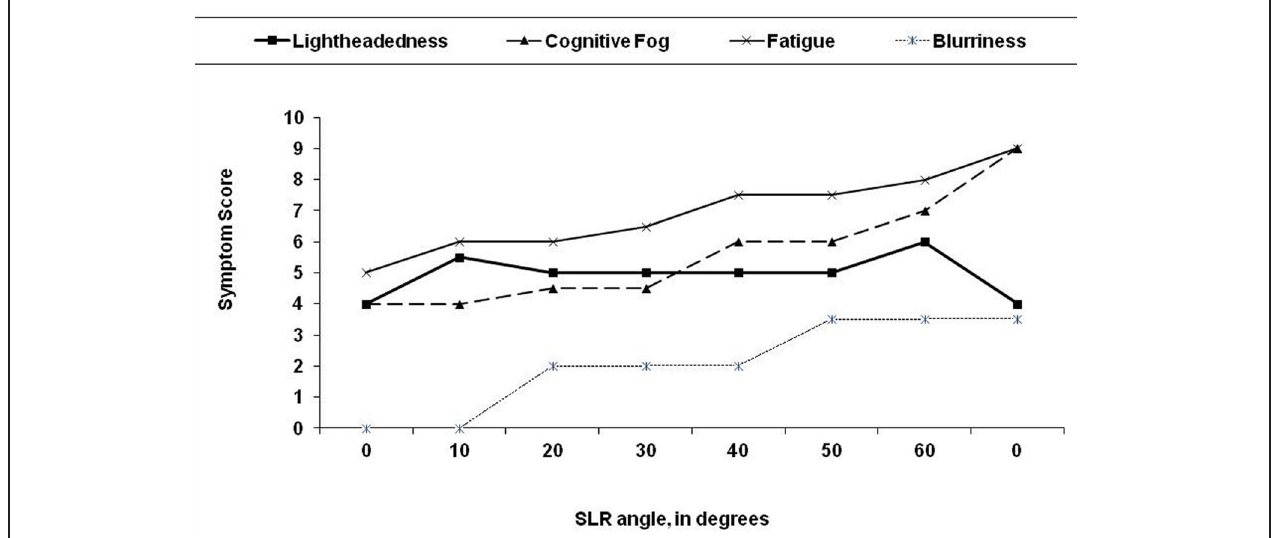
FIGURE 2 | Effect of 12min of progressive passive straight leg raise (SLR) on symptom severity in a 19 year old man with chronic fatigue syndrome. The leg was passively raised by 10 degree every